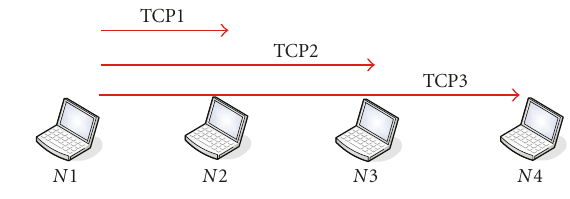
Figure 8: Network setup for the real-world experiment.